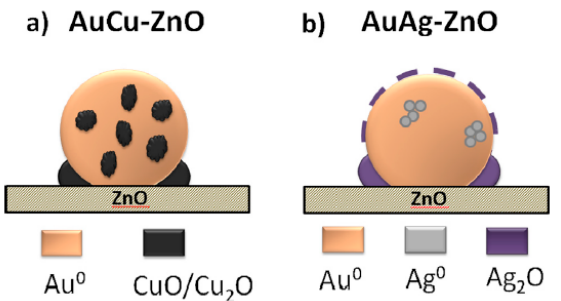
Figure 23. AuCu and AuAg structures in bimetallic catalysts loaded on ZnO. Reprinted with permission from reference [156]. Copyright 2018 Elsevier.